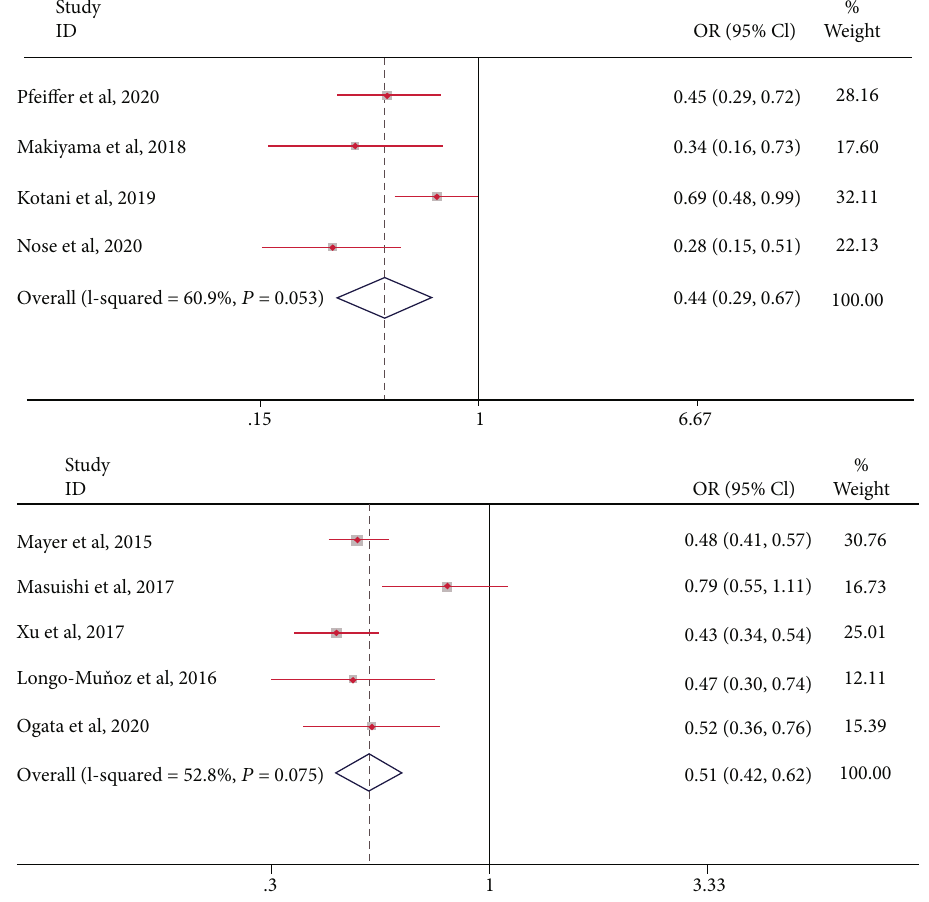
Figure 7: The odds ratio of mPFS treated with combination therapy with bevacizumab or TAS-102 monotherapy as the experiment